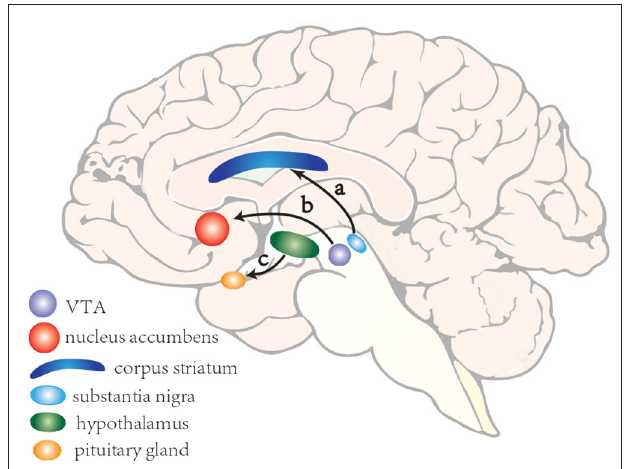
FIGURE 1 | A schematic illustration of three main dopaminergic pathways in central nervous systems. (a) the nigrostriatal pathway consisting of cell bodies in the substantia nigra whose axons terminate in the corpus striatum; (b) the mesocorticolimbic pathway (also known as the reward system), whose cell bodies are situated in the ventral tegmental area and whose axons project to parts of the limbic system; and (c) the tuberoinfundibular pathway, whose cell bodies are found in the ventral hypothalamus and project to the median eminence and pituitary gland.